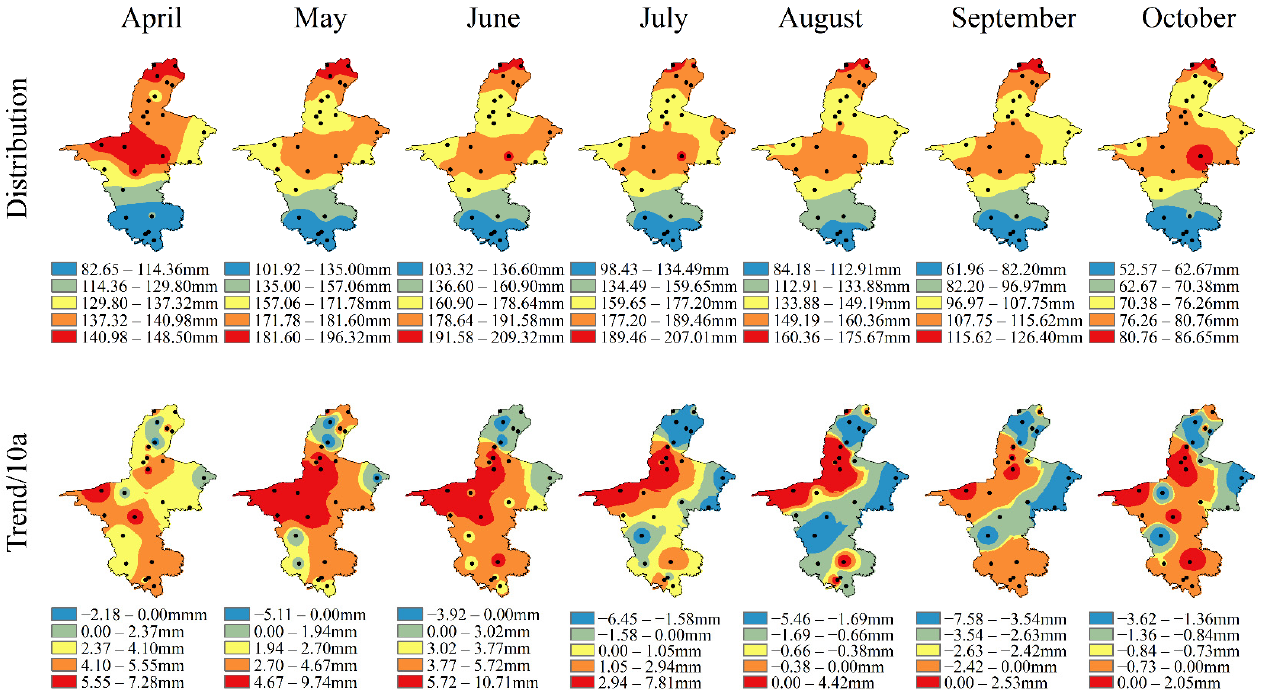
Figure 3. Spatial characteristics of monthly potential evaporation during the growing season in Ningxia Autonomous Region . Ningxia Autonomous